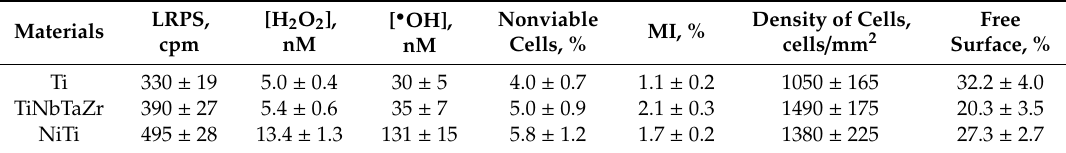
Table 1. Influence of Ti, TiNbTaZr and NiTi plates on the rates of generation of reactive oxygen species and cell growth /